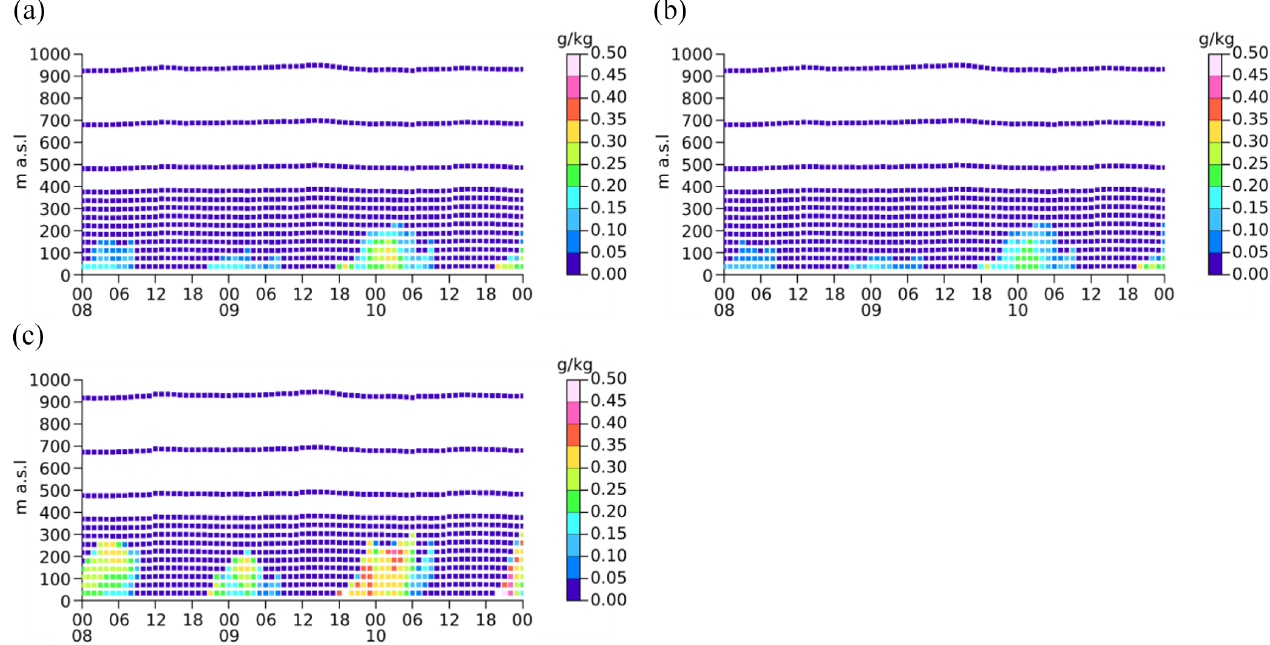
Figure 22. Profiles of LWC over time at Henties Bay for (a) CCN_300, (b) CCN_300_landsea, and (c) CCN_C10. Time is in UTC (site is UTC +